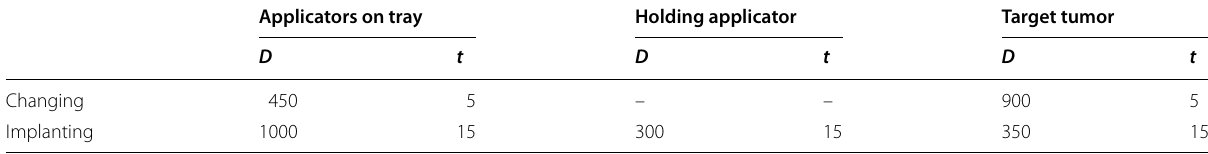
Table 1 Time and distance between doctor’s chest and seeds in the traditional treatment procedure: distance D (mm), time t